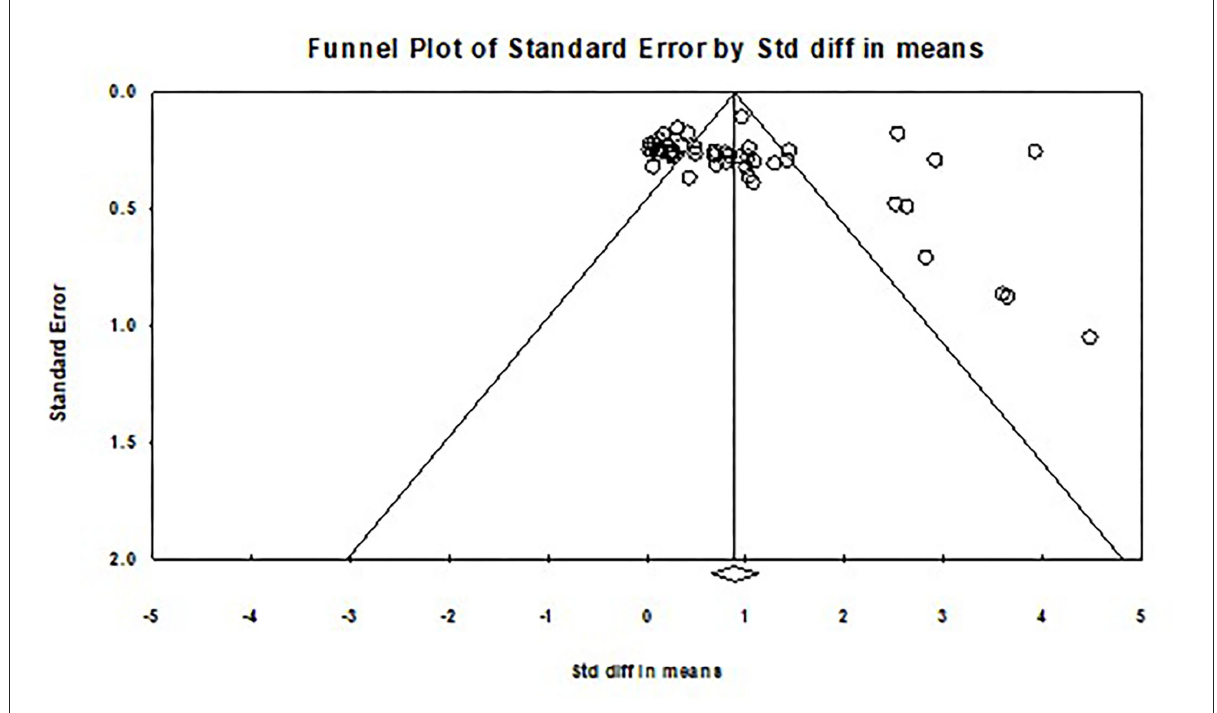
FIGURE2 Funnel plot of the overall effect of instruction on metaphorical